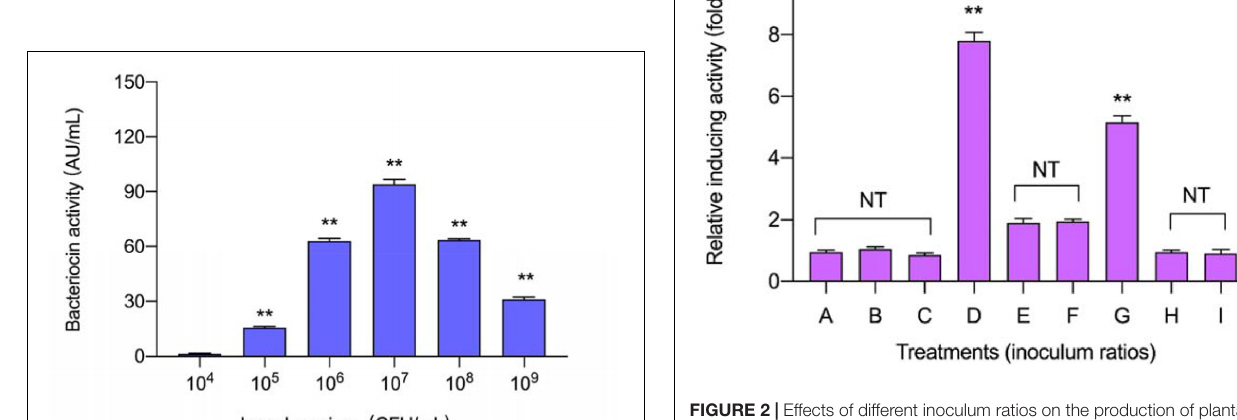
FIGURE 2 | Effects of different inoculum ratios on the production of plantaricin in co-culture. The relative bacteriocin activity was defined as the ratio of bacteriocin activity in co-culture to that in monoculture. The inoculum ratios of A–I are shown in Table 1 . NT indicates that there are no significant differences in the results in the control; * p < 0.05 and the ** p <